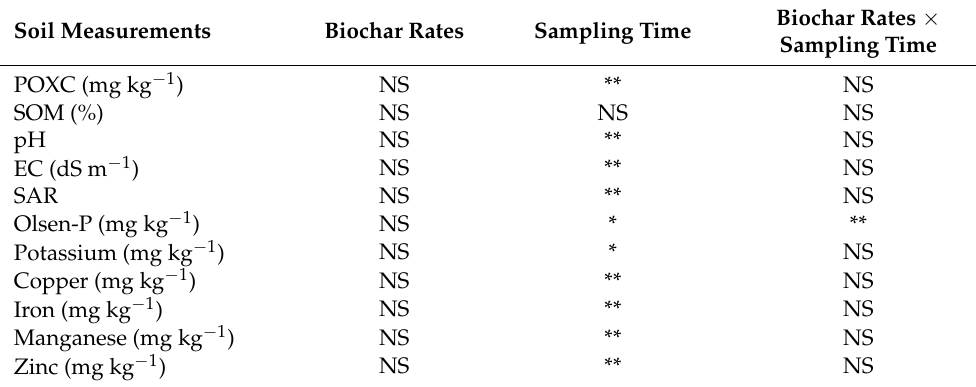
Table 3. Analysis of variance results for the effects of biochar rate, sampling time, and their interaction on measured soil parameters under pinto